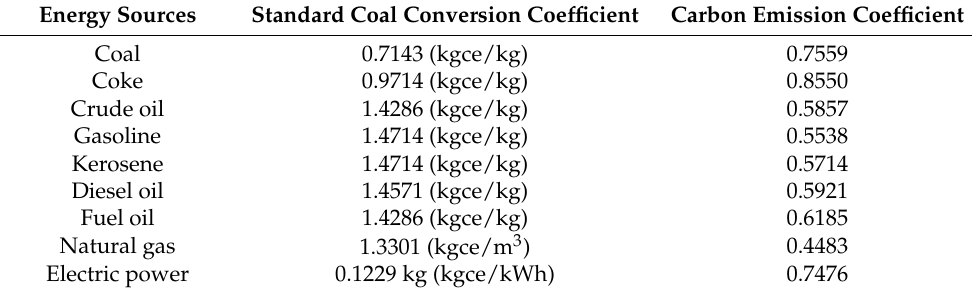
Table 1. Standard coal conversion coefficients and carbon emission coefficients of various en- ergy sources. Energy Sources Standard Coal Conversion